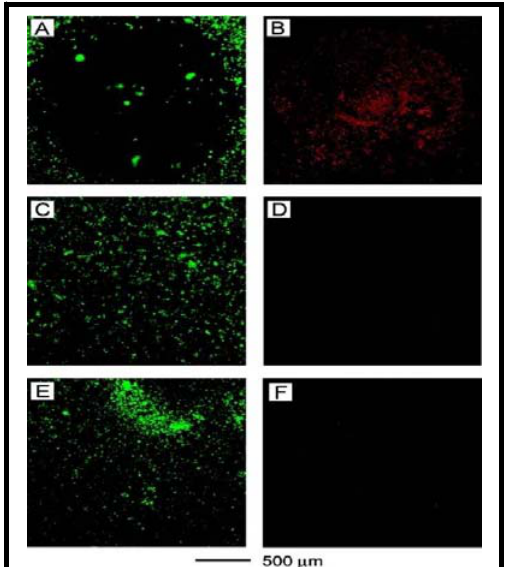
Figure 10. Gold nanocages (GNCs) for PTT. Cancer cells that were treated with GNCs and then irradiated showed a well-defined circular zone of dead cells as revealed by: ( A ) calcein AM assay (where green fluorescence indicates live cells), and ( B ) ethidium homodimer-1 (EthD-1) assay (where red fluorescence indicates dead cells). In the control experiment, cells irradiated under the same conditions but without GNCs treatment maintained viability, as indicated by ( C ) calcein fluorescence assay and ( D ) the lack of intracellular EthD-1 uptake. Cells treated with GNCs but irradiated at a lower power density remained alive, as shown by ( E ) calcein fluorescence assay and ( f ) the lack of intracellular EthD-1 uptake. Reproduced with permission